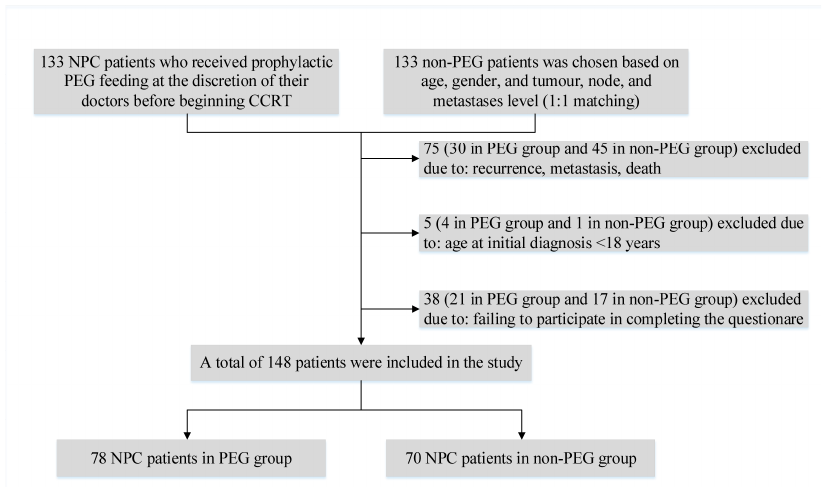
Figure 1. Flowchart of the study population. NPC, nasopharyngeal carcinoma; PEG, percutaneous endoscopic gastrostomy; CCRT, concurrent